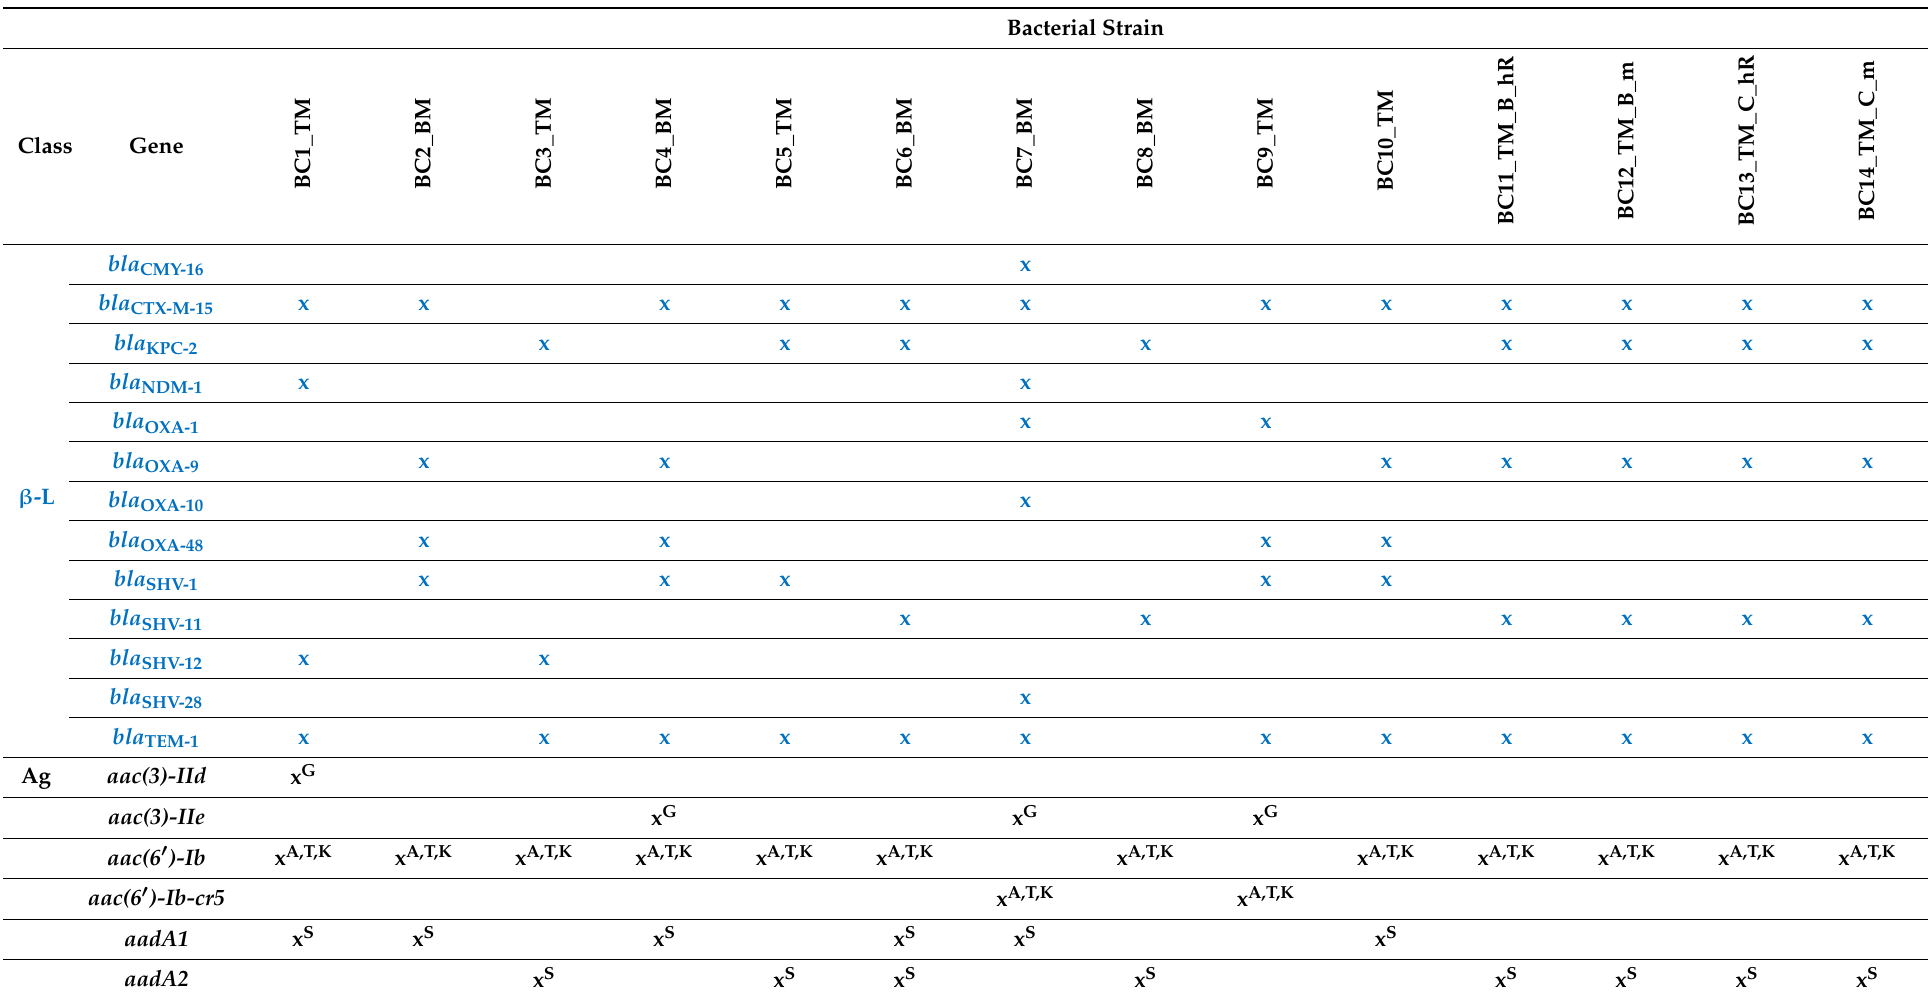
Table 4. Antimicrobial resistance determinants (except colistin) detected in all sequenced genomes.